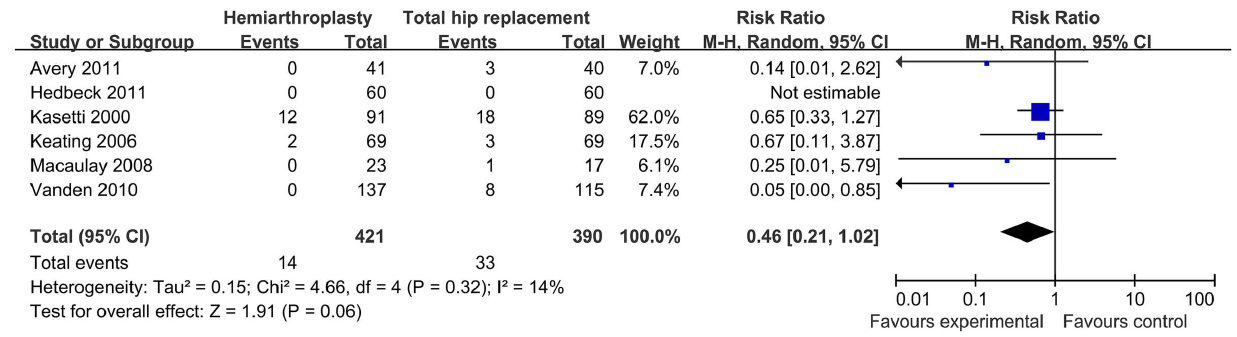
Figure 2. Statistical analysis of dislocation between HA (hemiarthroplasty) and THA (total hip arthroplasty) with Review Manager.